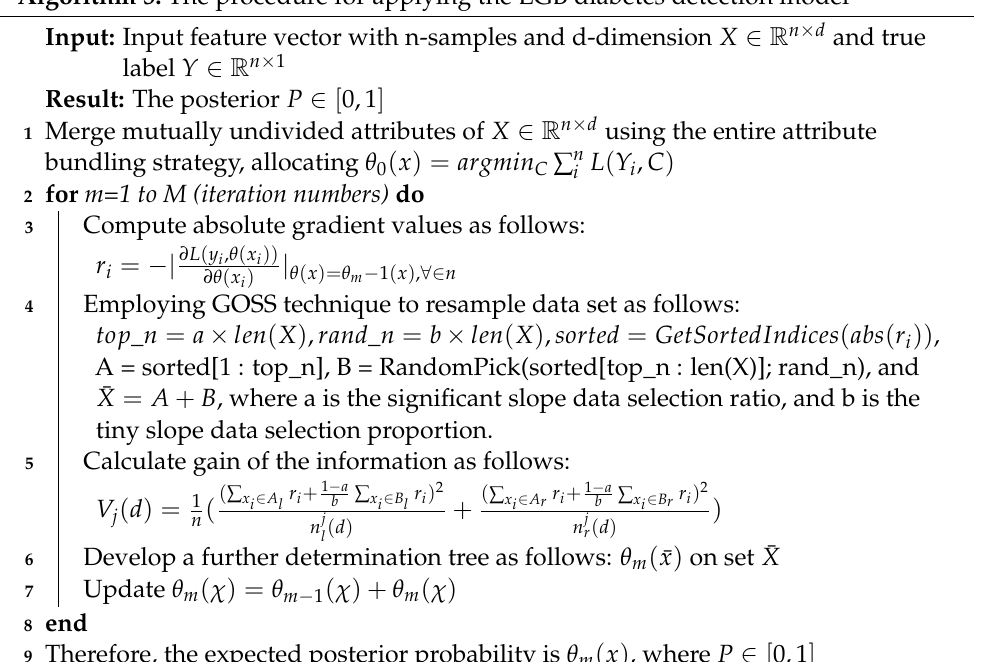
Algorithm 5: The procedure for applying the LGB diabetes detection